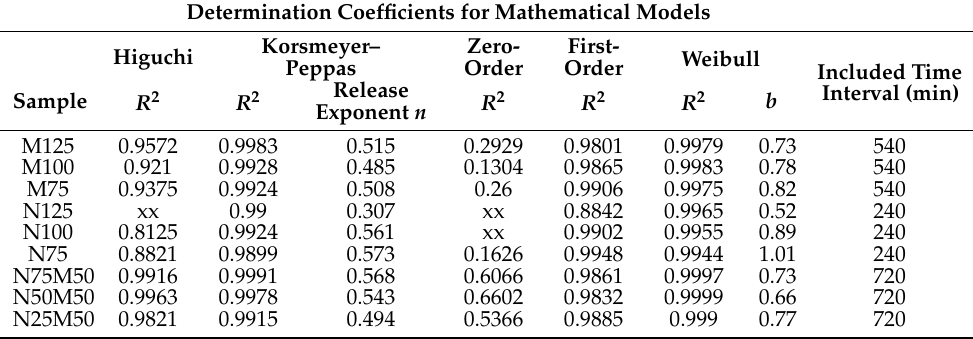
Figure 5. In vitro dissolution behaviour of the matrix tablets under USP apparatus 2 conditions. Table 3. Mathematical modelling and drug release kinetics from matrices.